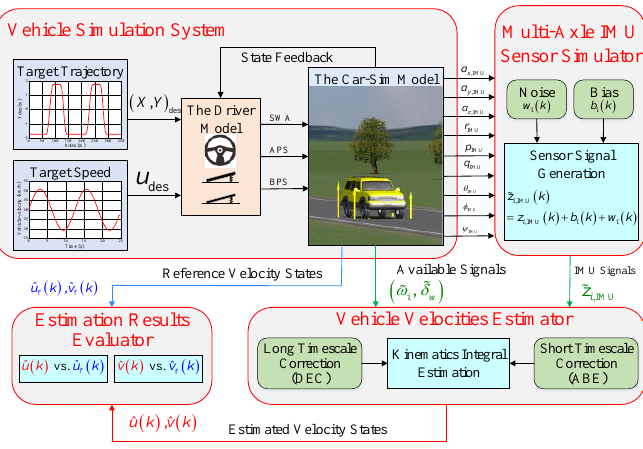
Figure 7. The CarSim-Simulink Co-simulation platform. Table 2. The specifications of the simulated electric vehicle.